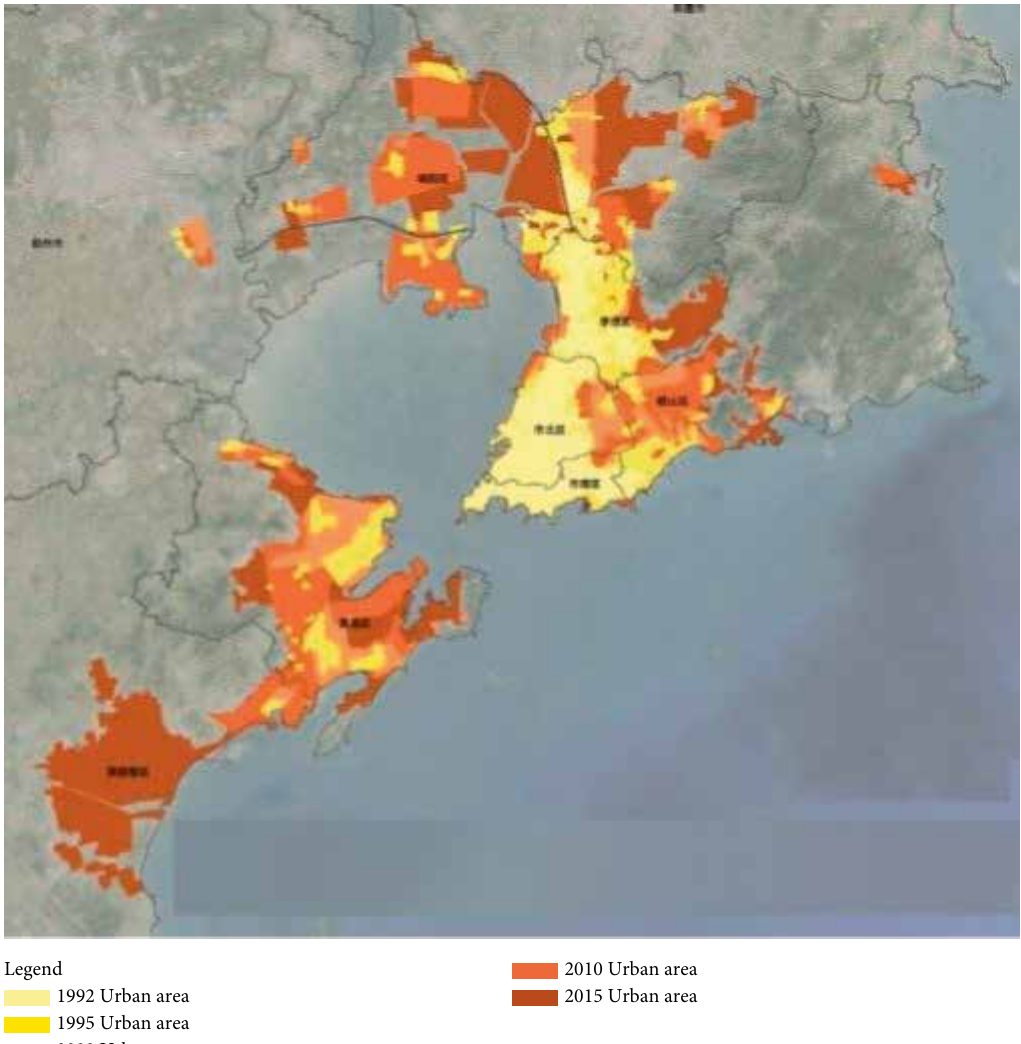
Figure 4: Urban expansion from 1992 to